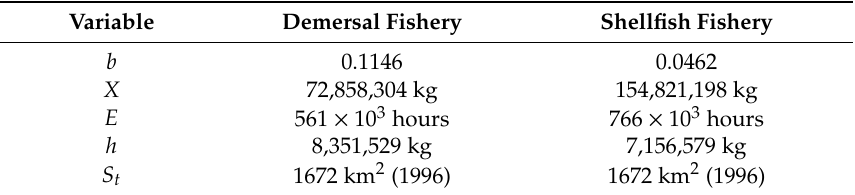
Table 2. Simulation results for mangrove-dependent fisheries,